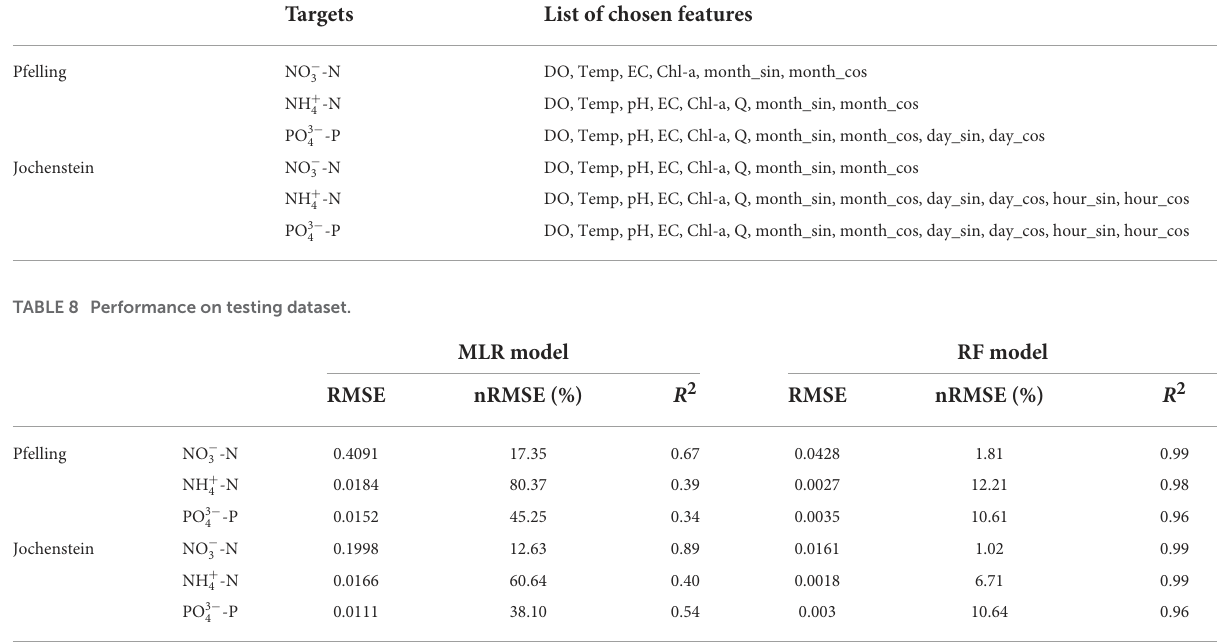
TABLE 7 List of chosen variables.